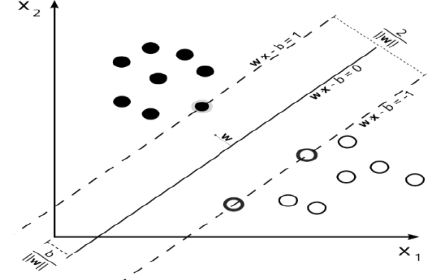
algorithm (15.07 cm, 1.54 and 0.58), a modified Chang algorithm in WESTDC (9.80 cm, 1.00 and 0.62), or the